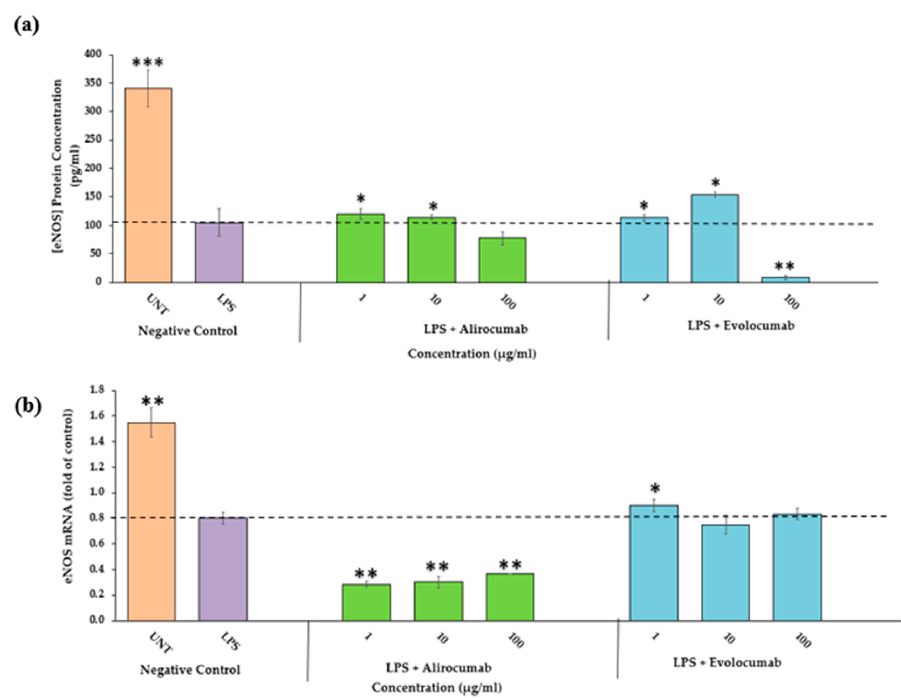
Figure 5. Effects of PCSK9 inhibitors on ( a ) eNOS in cell lysate protein expression ( b ) eNOS gene expression in cell pellets in LPS-stimulated HCAEC. Data are expressed as mean ± SD (n = 3). Statistical analysis: ANOVA, post-hoc with Bonferroni correction; * p < 0.05 ** p < 0.01 and *** p < 0.001 compared to HCAEC incubated with LPS alone. Abbreviation: UNT (Untreated),